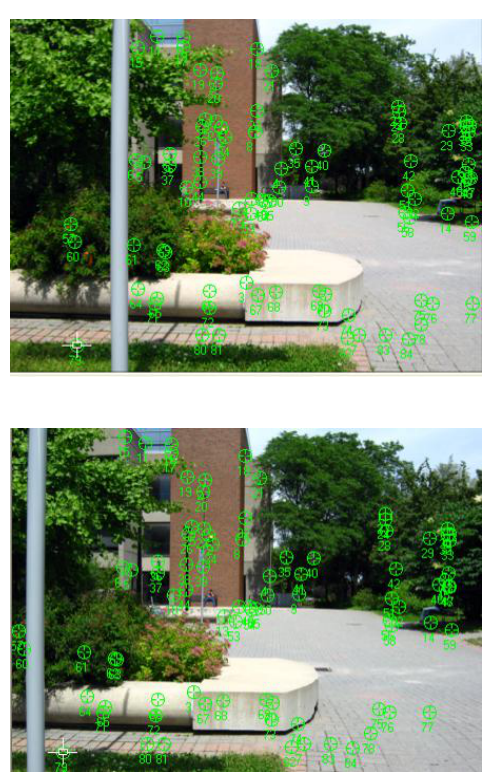
Figure 3. Field calibration stereopair (top: left camera , bottom: right camera)